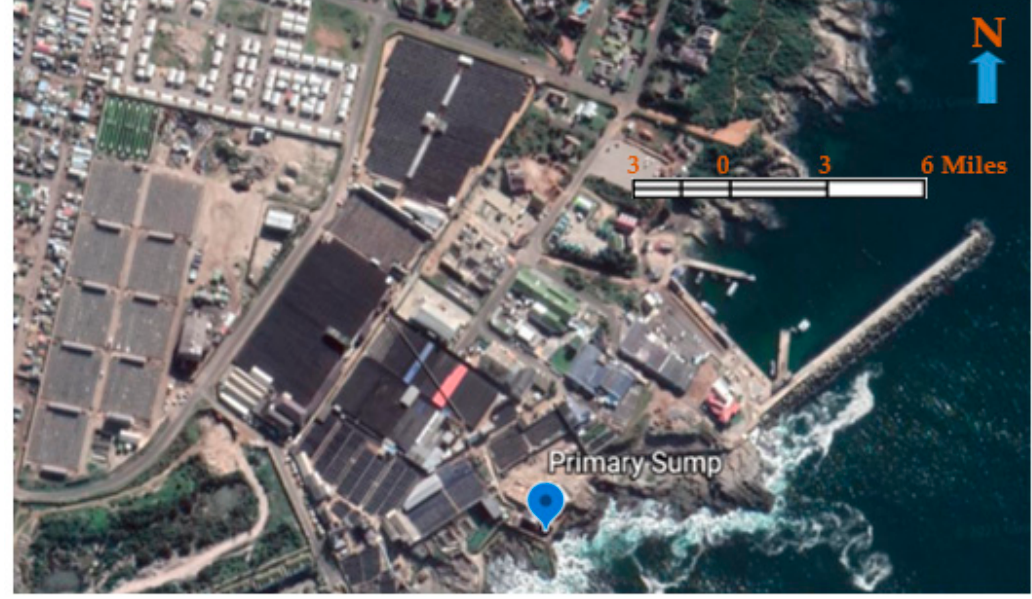
Figure 1. The water quality parameters monitoring location from the Abalone aquaculture industry in South Africa. A total of 20,730 sets of non-linear and non-stationary water quality parameters time- series data were collected at Abagold between November 2020 and January 2021. The wa- ter quality parameters included dissolved oxygen, turbidity, temperature, and pH. The